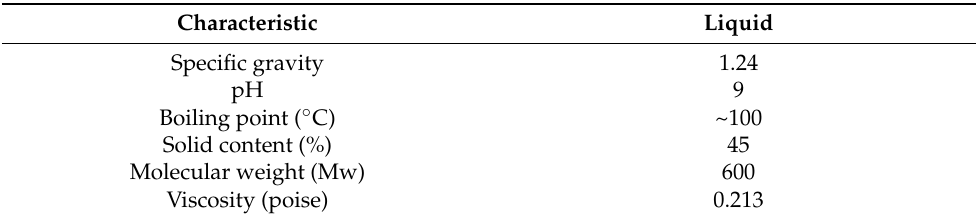
Table 1. Properties of low molecular weight phenol formaldehyde (LmwPF) resin used for impregna- tion treatment. Characteristic Liquid Specific gravity